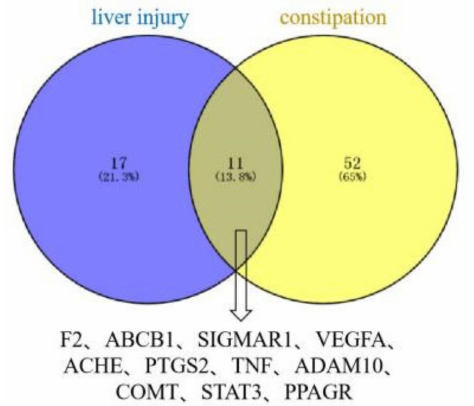
Figure 10. Liver injury-constipation intersectional target Venn